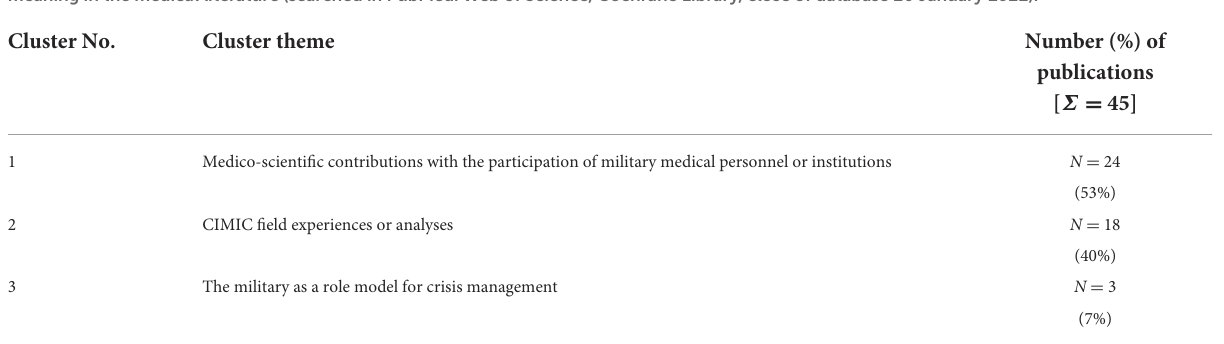
TABLE 1 Key concepts of civil-military interaction for disaster management during the COVID-19 pandemic: phenomenological clusters of meaning in the medical literature (searched in PubMed. Web of Science, Cochrane Library, close of database 26 January 2022). Cluster